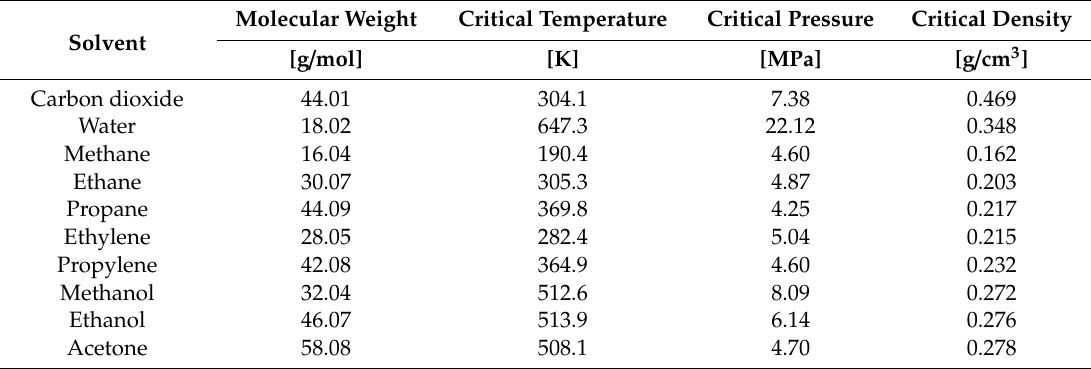
Table 1. Chemical solvents employed in supercritical fluids extraction (SFE) and their critical characteristics